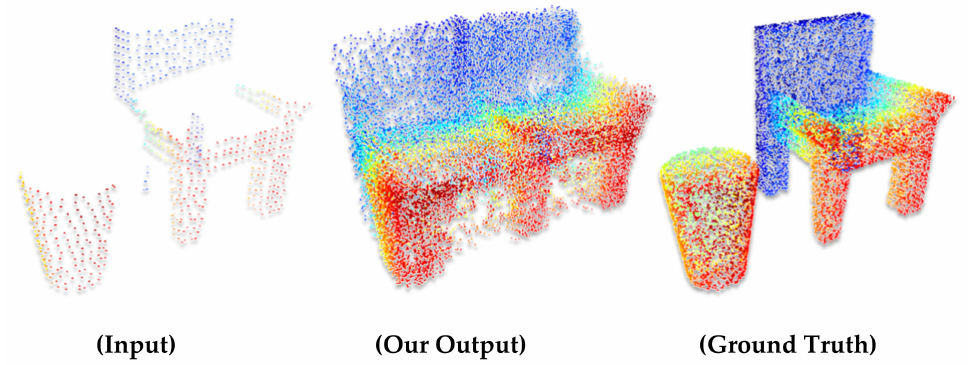
Figure 10. Failure example of objects containing independent